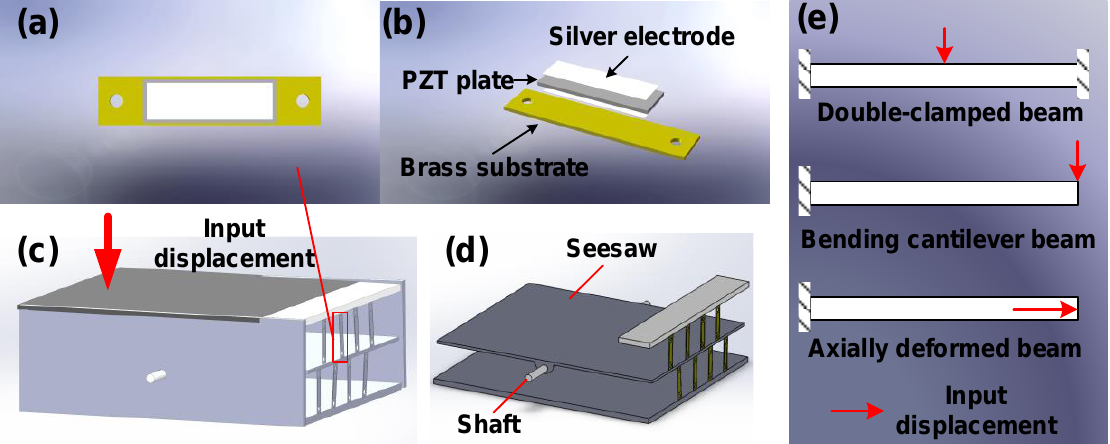
Figure 1. The schematic diagram for the proposed PPEH: ( a ) a single ADB with a PZT plate; ( b ) exploded view of an ADB; ( c ) the structural mode of proposed PPEH; ( d ) the structural mode of seesaw and ADBs; ( e ) the loading ways for conventional beams ( up and middle ) and ADB ( below ).